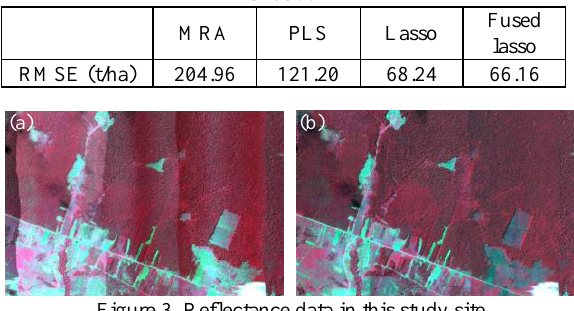
Table 1 Comparison of prediction accuracy in 50 times cross-